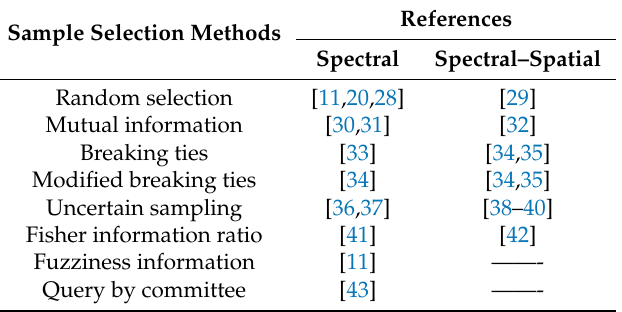
Table 2. Different sample selection methods used in Active Learning frameworks for hyperspectral image classification in the recent